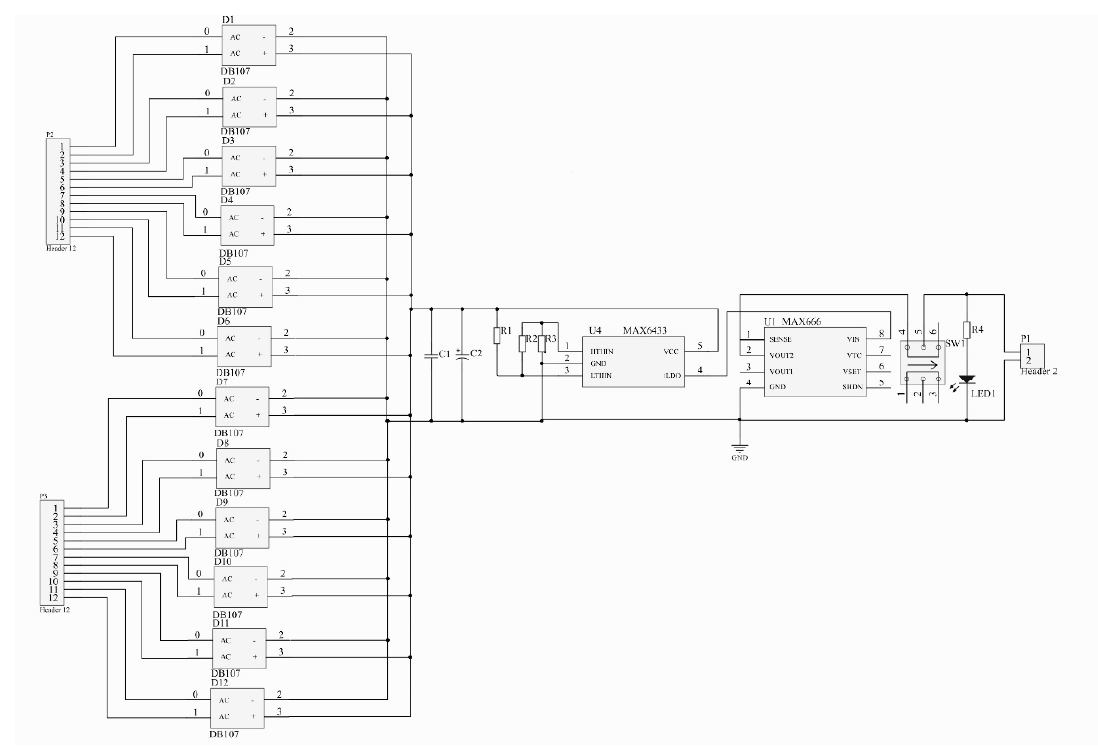
Figure 6. Commutating and voltage-stabilizing circuit.